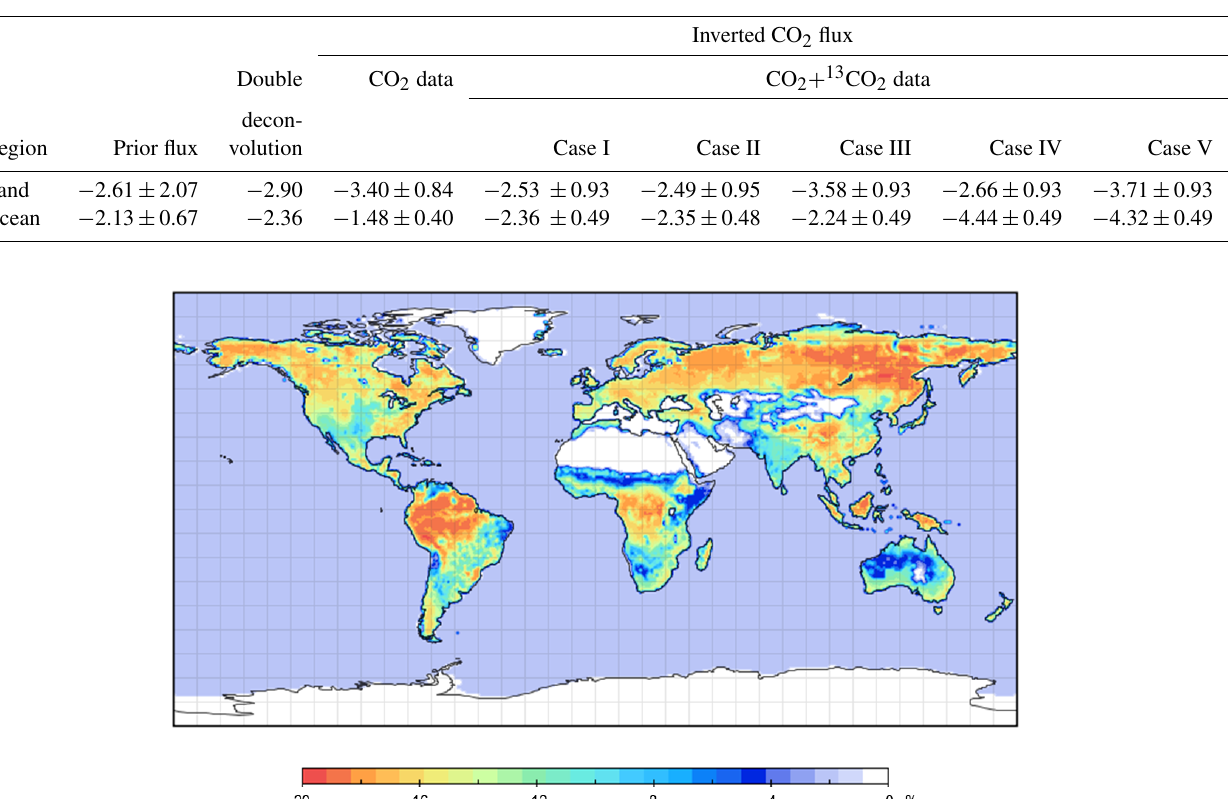
Table 3. Inverted fluxes (Pg Cyear − 1 ) , averaged for 2002–2004, for land and ocean regions with (CO 2 + 13 CO 2 ) and without (CO 2 -only) 13 C constraint. The negative sign denotes the flux from the atmosphere to the surface (sink). Various treatments are made to 13 C discrimination and disequilibrium fluxes represented by the following cases. Case I: full consideration of the regional differences in discrimination and disequilibrium; case II: same as case I, but the annual photosynthetic discrimination ratio is set at a constant of − 14 . 1‰, although it is monthly variation pattern as modelled by BEPS is retained; case III: same as case I, but the disequilibrium flux over land is ignored; case IV: same as case I, but the disequilibrium flux over ocean is ignored; case V: same as case I, but the disequilibrium flux over both land and ocean is ignored.